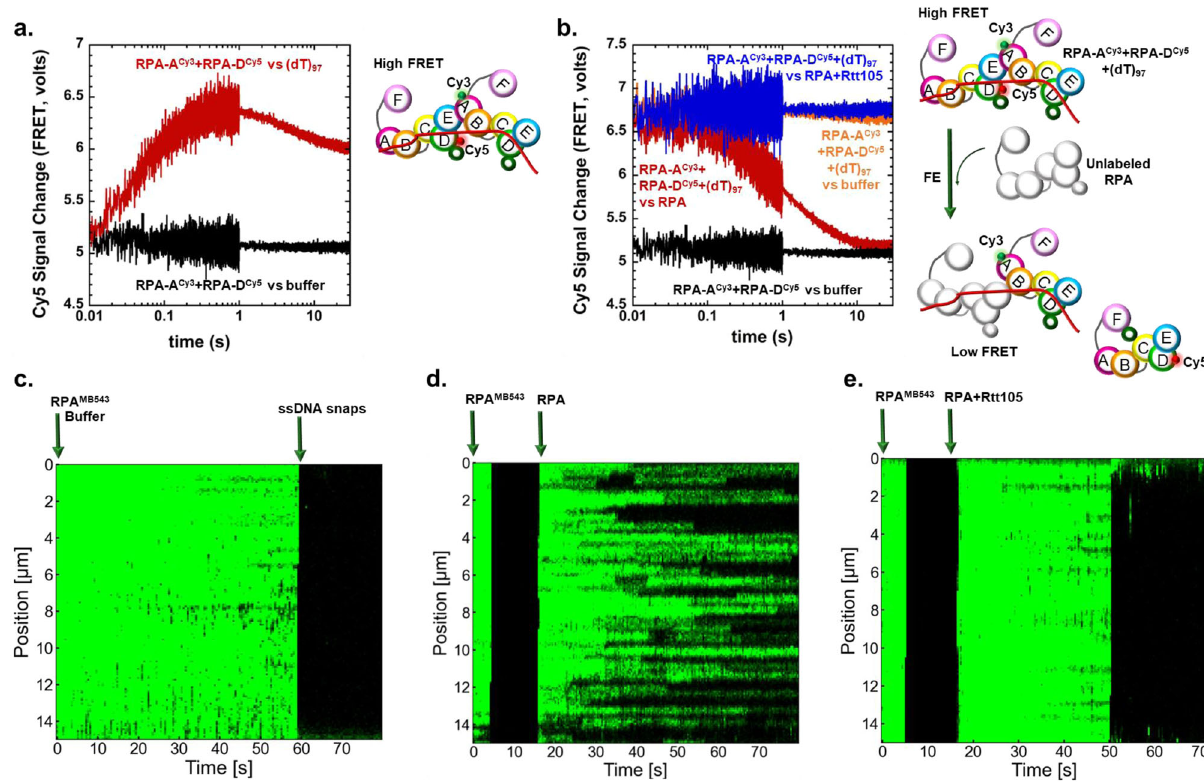
Fig. 6 | Rtt105 inhibits facilitated exchange activity of RPA. a A high FRET complex is formed when multiple molecules of RPA-DBD-A Cy5 and RPA-DBD-D Cy3 bind to a (dT) 97 substrate (red). FRET-induced Cy5 fl uorescence is not observed in the absence of DNA (black). b Facilitated exchange (FE) activity was measured by mixing preformed [RPA-DBD-A Cy5 :RPA-DBD-D cy3 :(dT) 97 ] complexes with unlabeled RPA (red) resulting in a loss of Cy5 fl uorescence. Rtt105 inhibits the FE activity as preformed Rtt105:RPA complexes do not perturb the Cy5 signal (blue). Control experiments in the absence of unlabeled RPA (orange) or DNA (black) are also shown as reference for the high and low FRET-induced Cy5 fl uorescence